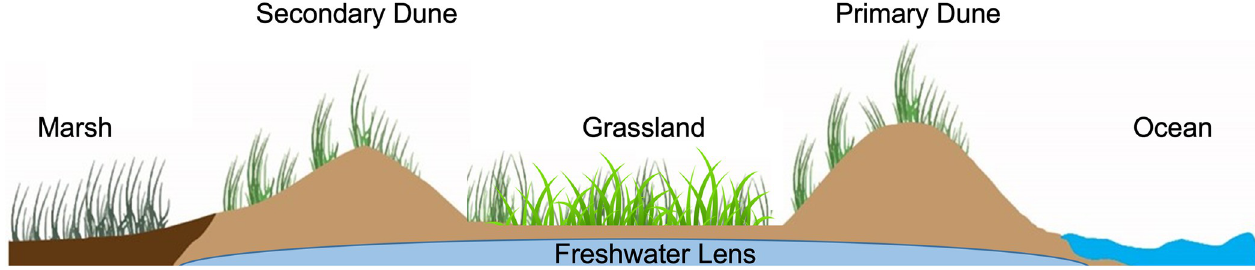
Fig 1. Cross-section schematic of barrier